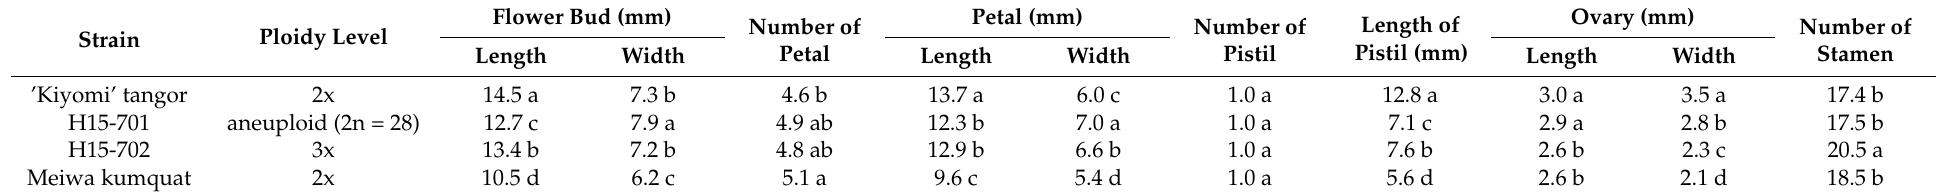
Table 4. Morphological characteristics of flowers in ‘Kiyomi’ tangor, Meiwa kumquat, and their hybrids. Different letters represent significant differences in Tukey’s multiple range test, 1% level (n = 20).